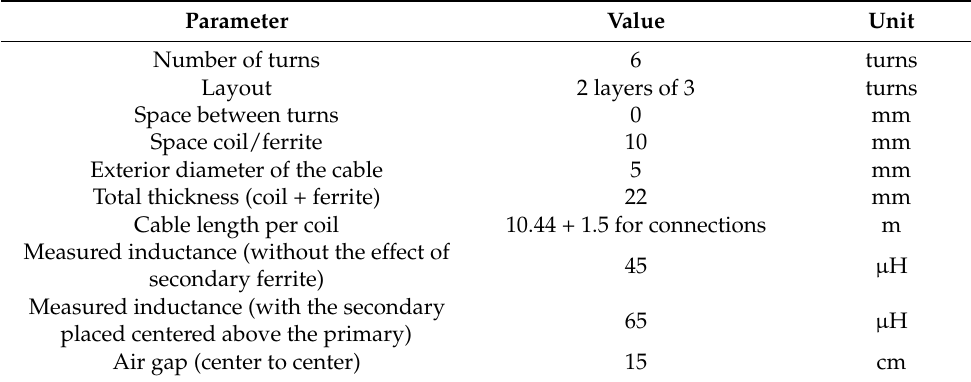
Figure 1. Model of the implemented coils + Ferrite plates for shielding. Table 1. Characteristics of the used coils.